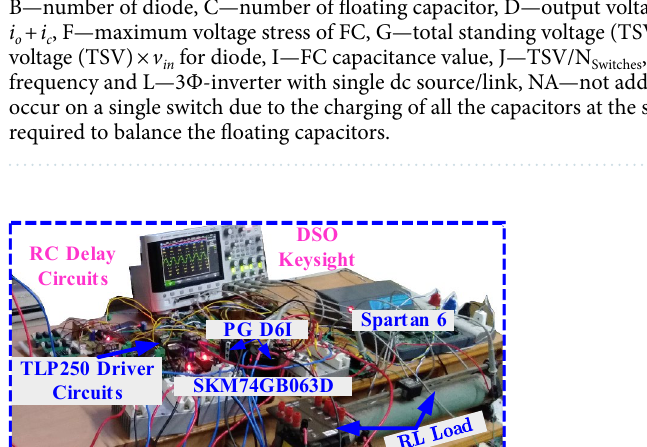
Table 3. Components comparison of recent 7L boost ANPC type SCMLI topologies. A—number of switches, B—number of diode, C—number of floating capacitor, D—output voltage gain, E—number of switches in